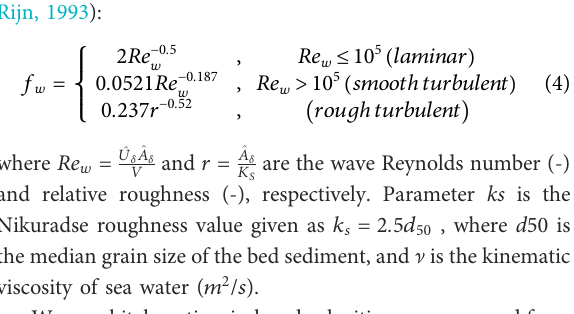
Period 1 Period 2 All Calm Windy All